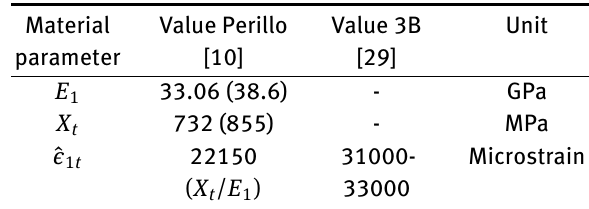
Table 1: Material